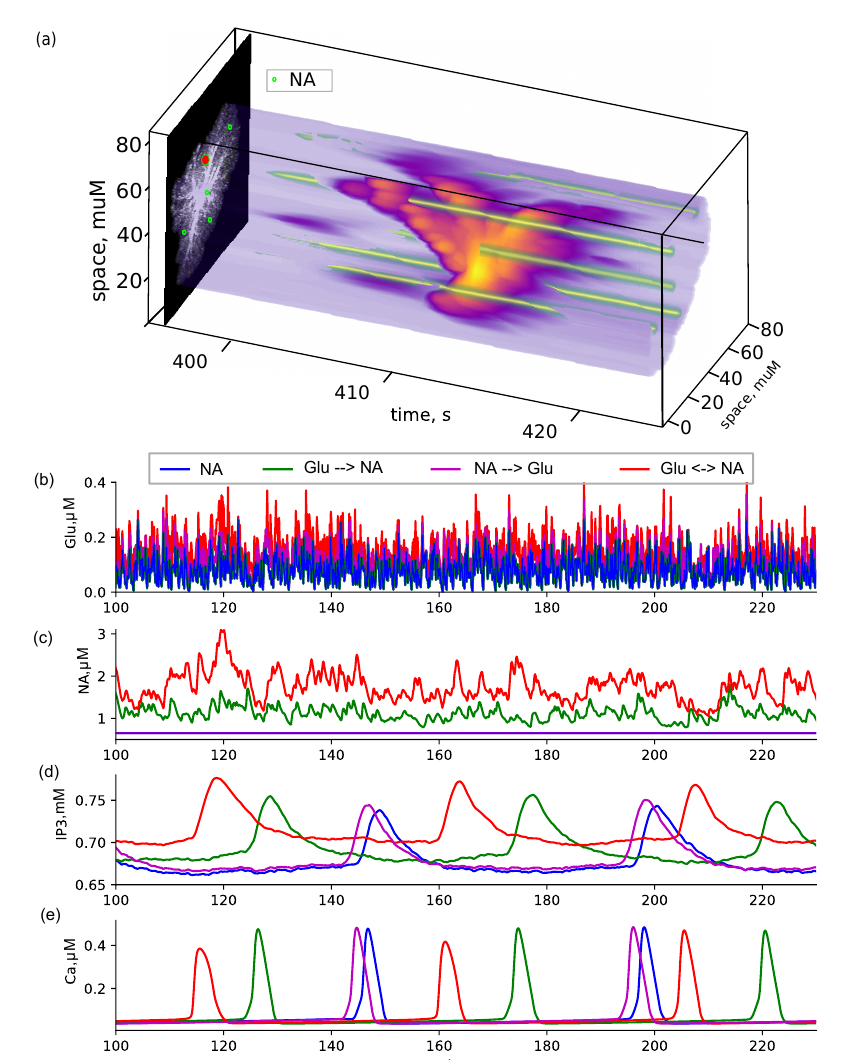
Figure 5. Testing GANE pathways. ( a ) Calcium wave initiated near one of the NA release cites, marked with a red dot. ( b , c )—NA release is amplified by the reciprocal coupling with Glu spillover from nearby synapses; ( d , e )—reciprocal coupling between Glu and NA provides increased IP 3 level ( d ) and facilitates calcium oscillations ( e ). Blue lines: no interaction between NA and Glu; green: Glu facilitates NA release; magenta: NA enhances Glu release probability; red: both feedback loops are turned on. Parameter set 3 was